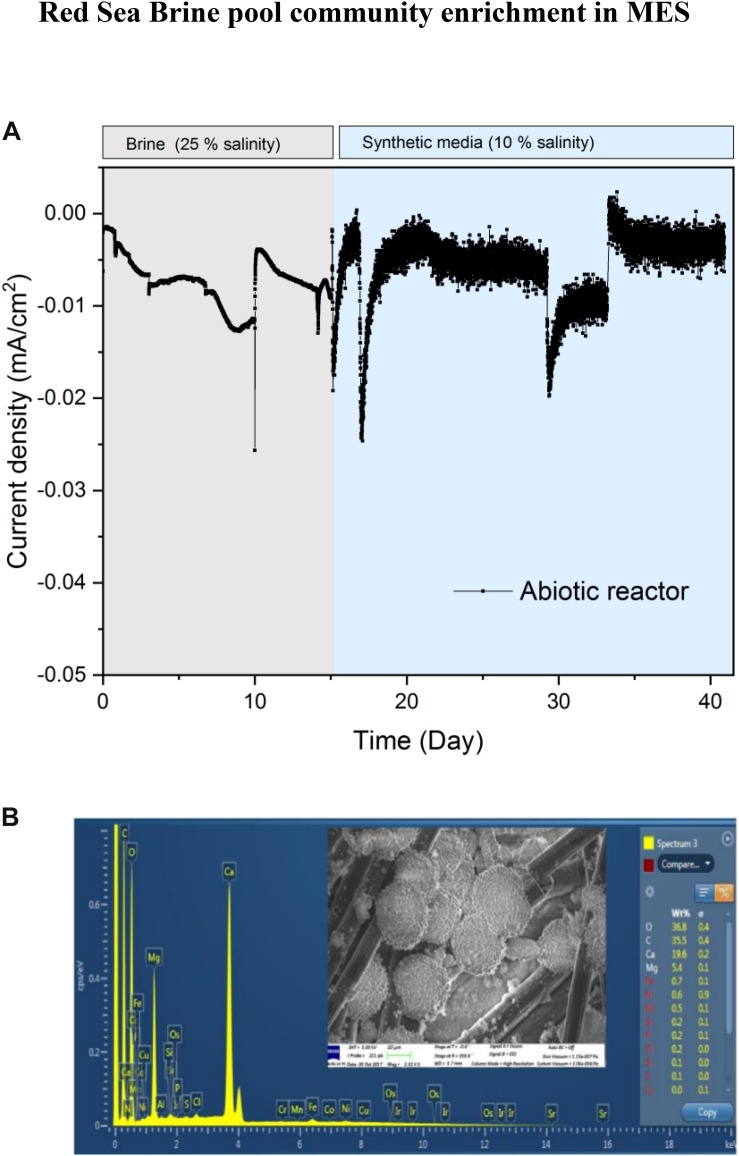
(A) Current density profile of abiotic MES reactor operated at −1.0 V vs. Ag/AgCl cathode potential with sterile brine electrolyte (25% salinity) and synthetic saline media (10% salinity) as electrolyte. (B) EDX analysis of abiotic carbon felt cathode of the control experiment with sterile brine pool solution (25% salinity). The inset represents SEM image showing salt deposits on the cathode.